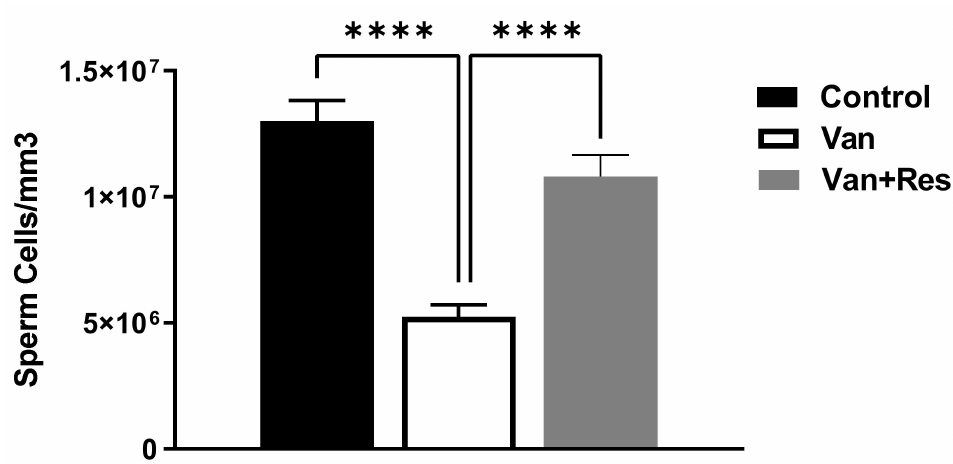
Figure 6. The effect of the resveratrol and vancomycin administration on the sperm during the experiment. **** p < 0.0001.